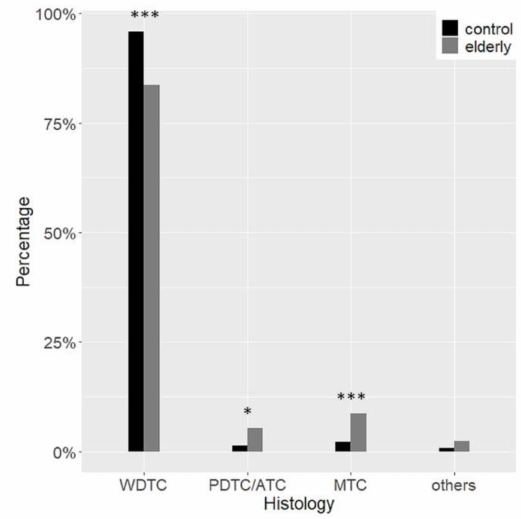
Figure 4. Histological diagnoses. Differences between the elderly (grey) and the control (black) group are highlighted. WDTC, well-differentiated thyroid carcinoma; PDTC, poorly-differentiated thyroid carcinoma; ATC, anaplastic thyroid carcinoma; MTC, medullary thyroid carcinoma * p < 0.05 *** p < 0.001.